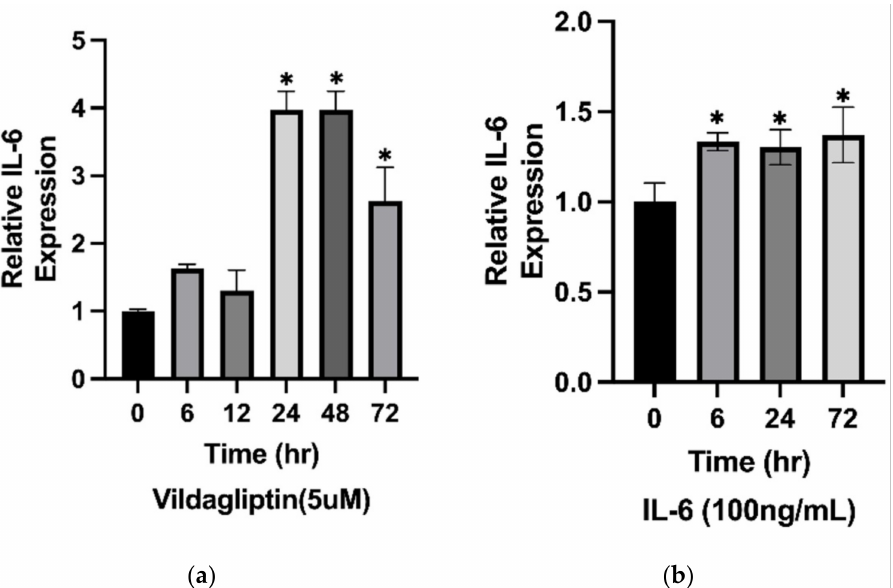
Figure 5. The expression of IL-6 was stimulated in keratinocytes treated by either vildagliptin or IL-6. ( a ) Checked by qPCR, the expression of IL-6 was found to have increased when HaCaT cells were treated by vildagliptin (5 µ M). ( b ) By adding IL-6 (100 ng/mL) in the HaCaT cell culture medium, the endogenous IL-6 increased in a time-dependent manner checked by qPCR with GAPDH as reference gene. * [ p <